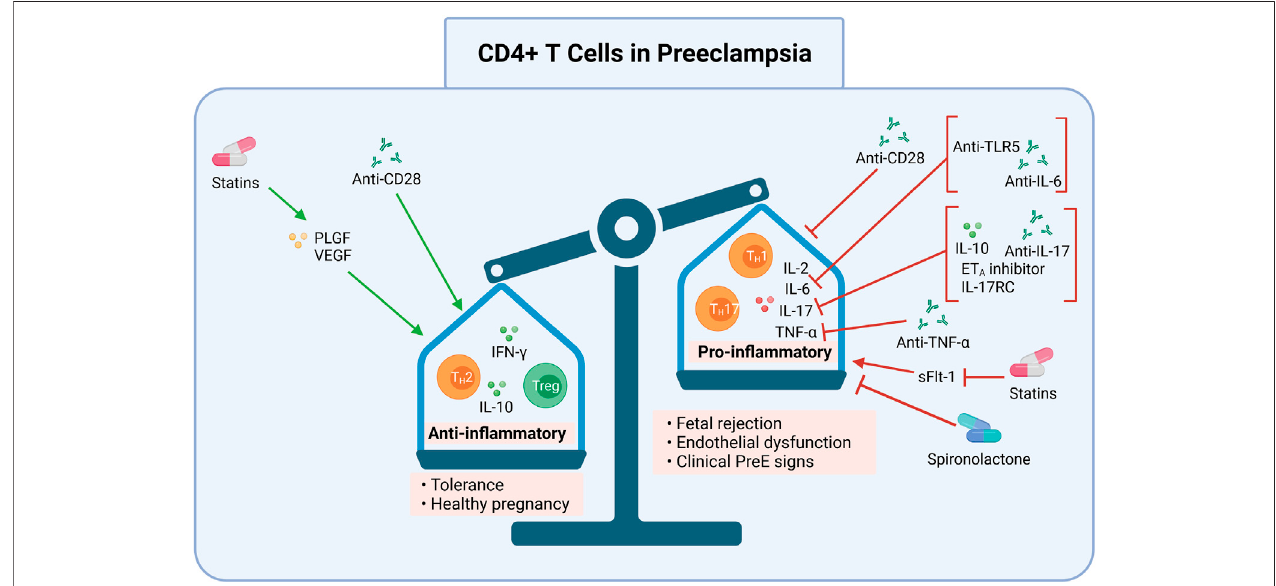
FIGURE 2 | CD4+ T cell pro-in fl ammation and processes may be targeted in preeclampsia. Induction of anti-in fl ammatory CD4+ T cells (Th2s) and Tregs, and inhibition of pro-in fl ammatory CD4+ T cells (Th17s, TH1s) may be one pathway for preeclampsia treatment and prevention. Collectively, modulation of these processes may ameliorate the overly pro-in fl ammatory immune response in preeclampsia. Shifting the ratio of pro-to anti-in fl ammatory CD4+ T cells may prevent preeclampsia by allowing proper placentation and reducing resultant oxidative stress. This can be done by 1) promoting an anti-in fl ammatory milieu (Th2, Treg, IFN- γ , IL-10) with anti-CD28, statins that induce PLGF and VEGF, or 2) inhibiting a pro-in fl ammatory milieu (Th1, Th17, IL-2, IL-6, IL-17, and TNF- α ) with anti-CD28 or spironolactone, or inhibiting sFlt-1using statins. Speci fi c cytokines may also be inhibited, such as IL-6 by anti-TLR5 or anti-IL-6; IL-17 by IL-10, ET A inhibitors, IL-17RC, and anti-IL-17; or TNF- α byanti-TNF- α .Theanti-in fl ammatoryCD4+Tcellresponsemayresultintoleranceandahealthypregnancywhilethepro-in fl ammatoryCD4+Tcellresponsemay leadtofetalrejection,endothelialdysfunction,andclinicalpreeclampsiasigns.DC,dendriticcells;mAbs,monoclonalantibodies;Th,HelperTcell;Treg,regulatoryTcell; IL, interleukin; IFN- γ , interferon gamma; TNF- α , tumor necrosis factor alpha; anti, antibody; ET A , endothelin-1 receptor A; sFlt-1, soluble Fms-like Tyrosine Kinase-1; PLGF, placental growth factor; VEGF, vascular endothelial growth factor; IL-17RC mouse IL-17 receptor C; TLR5, toll like receptor 5. Created with https://